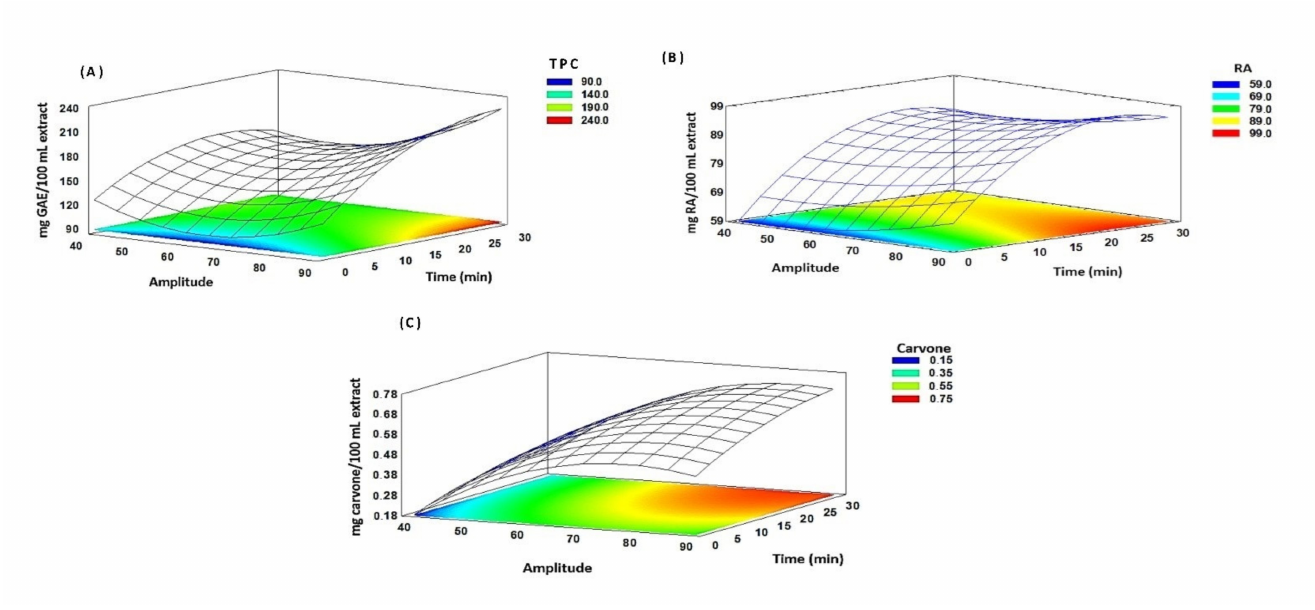
Figure 4. Response surface and contour plot effect of the extraction and amplitude for total polyphe- nols (TPC) ( A ), rosmarinic acid content (RA) ( B ), and carvone ( C